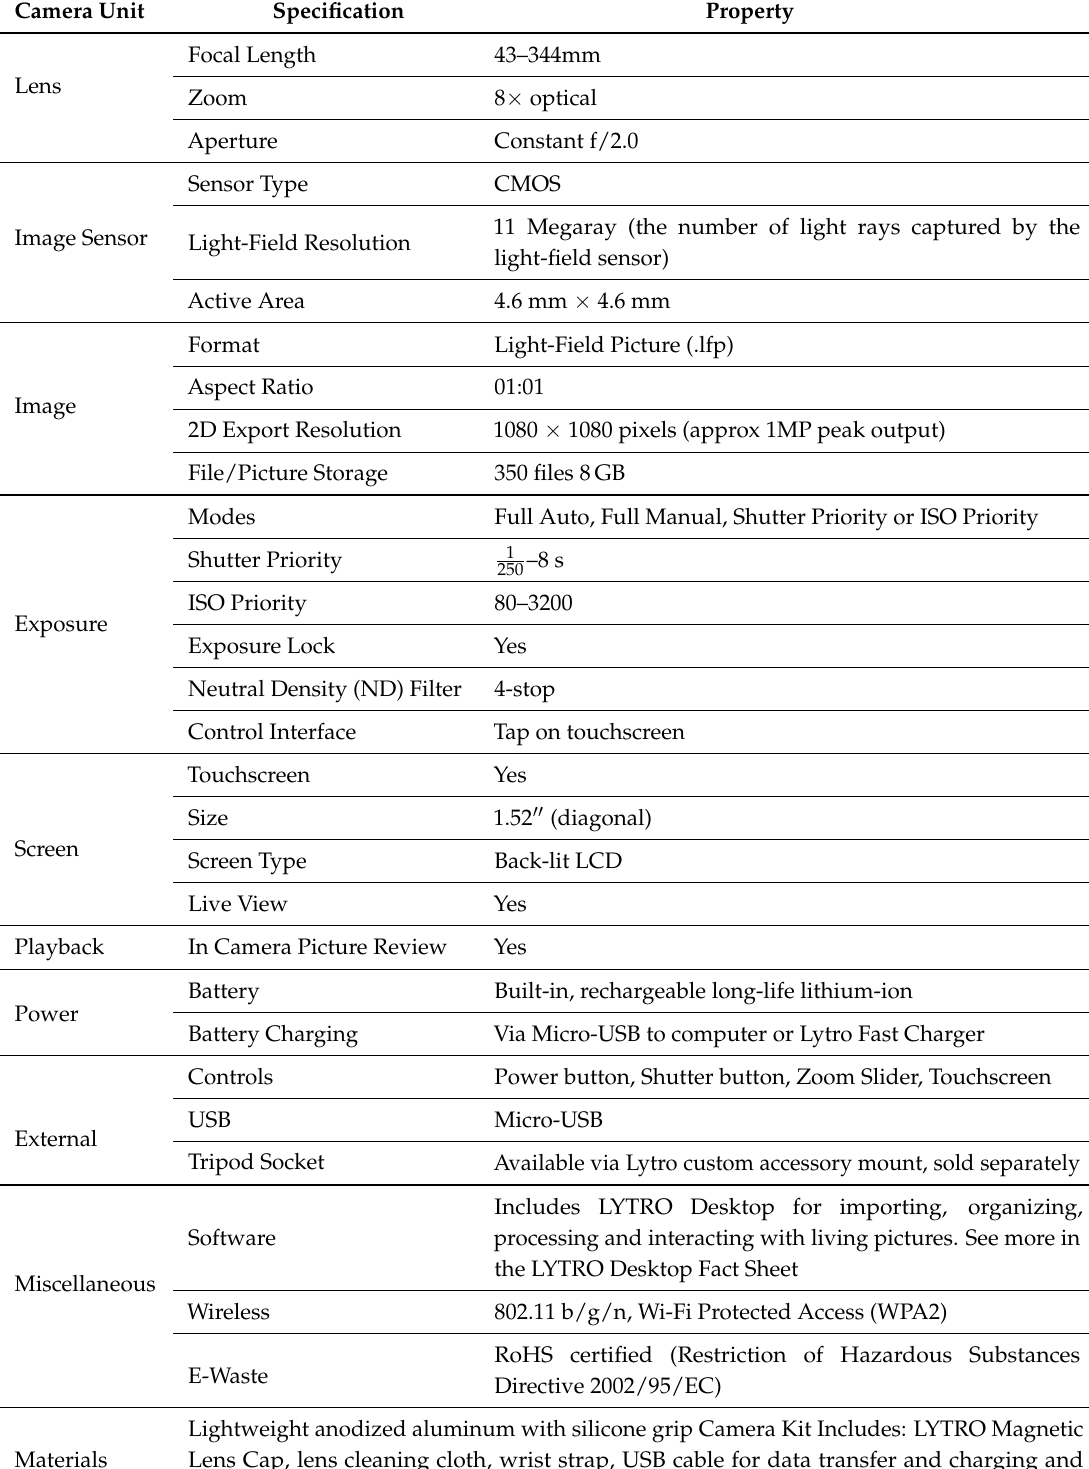
Table 1. Lytro specifications